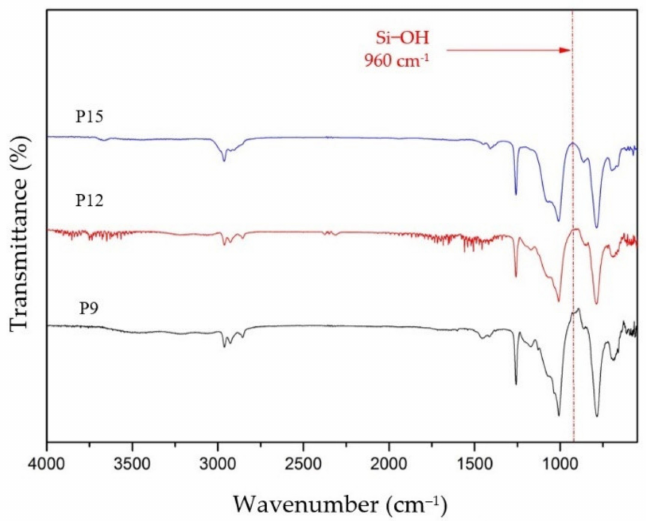
Figure 2. Fourier transform infrared (FTIR) spectra of the hybrid PDMS membranes with different TEOS loading ratios (9.4, 12.6 and 15.7